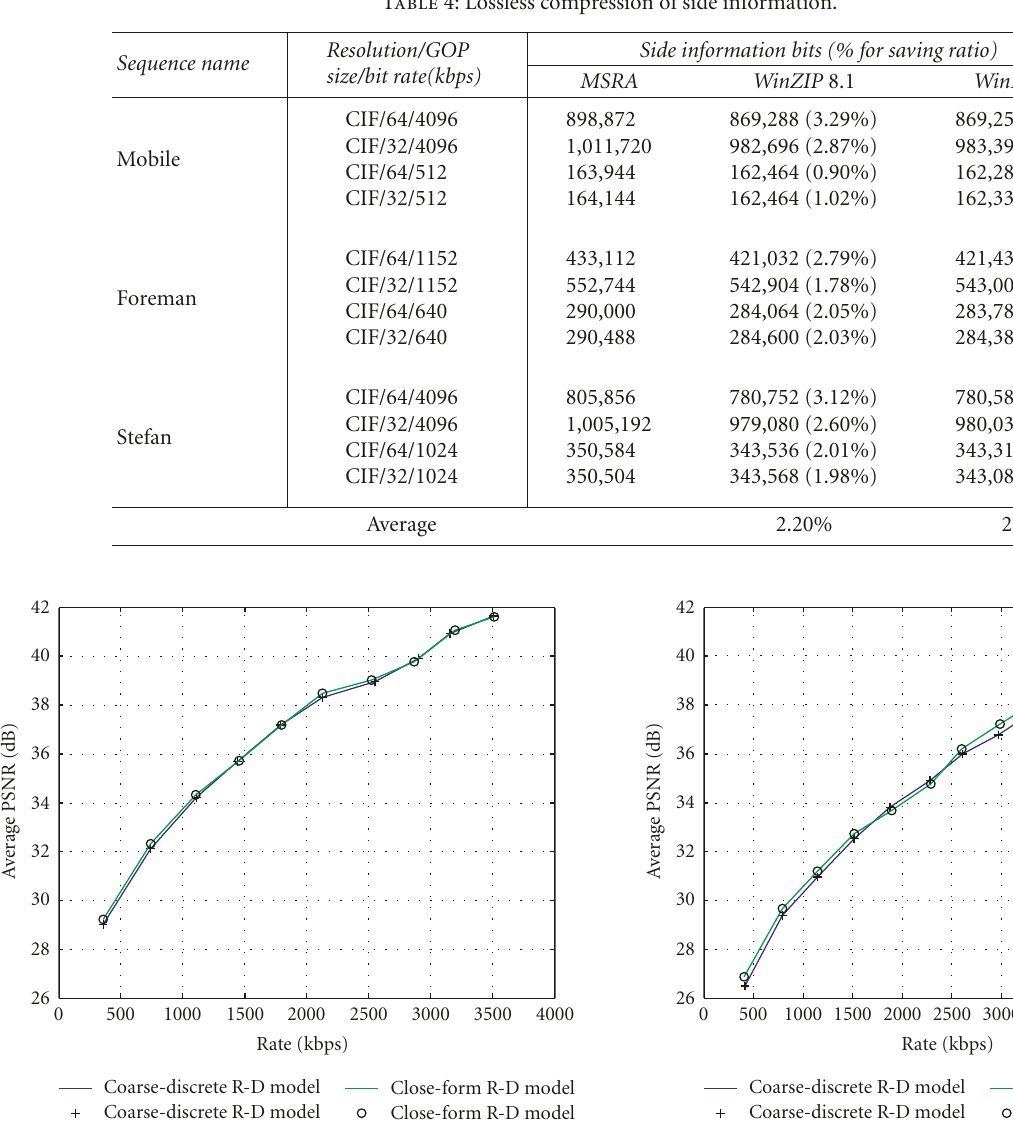
Figure 12: Content-adaptive FEC test for the Mobile sequence (5%